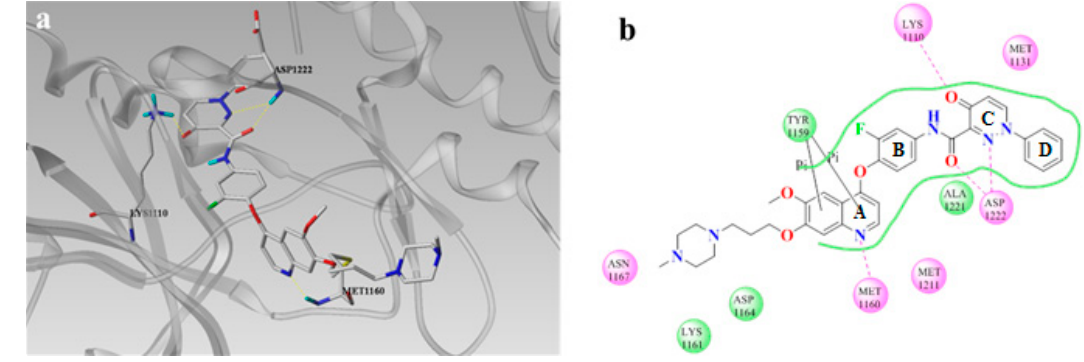
Figure 4. The docking mode of 53 with c-Met. ( a ) The 3D interaction map between the 53 and c-Met, the hydrogen bonds was colored with yellow; ( b ) 2D depiction of the ligand-protein interaction.